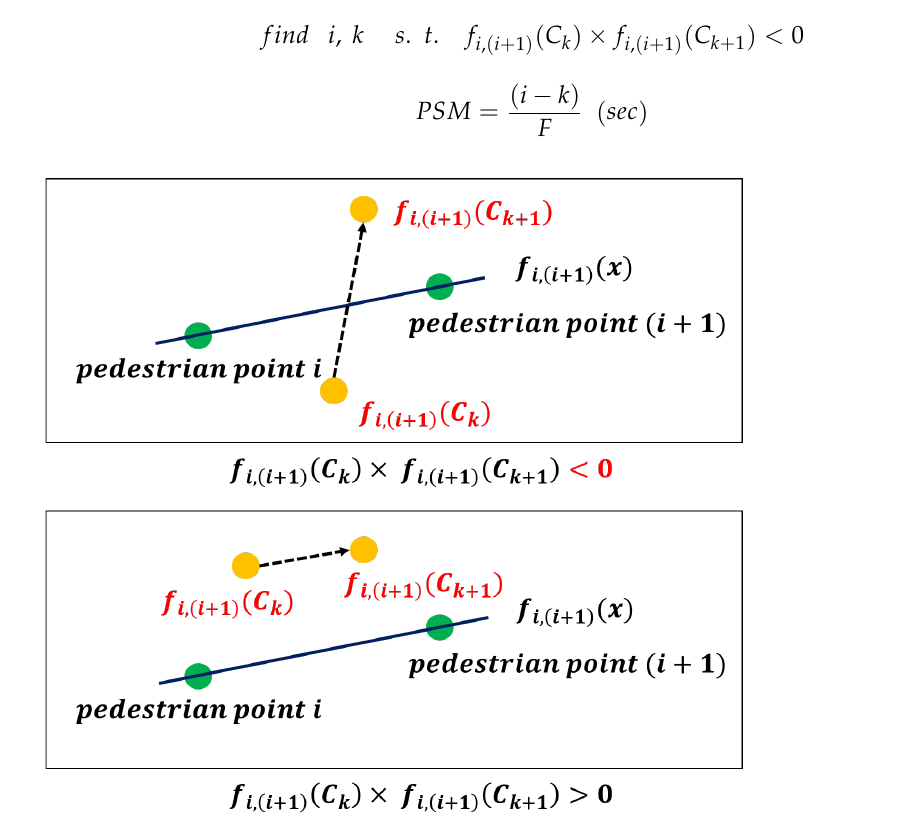
Figure 10. Process of finding conflict points by using IVT.